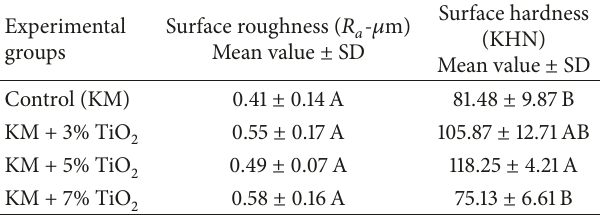
Table 1: Surface roughness ( 𝑅 𝑎 - 𝜇 m) and hardness (KHN) mean values and standard deviation (SD) for the experimental